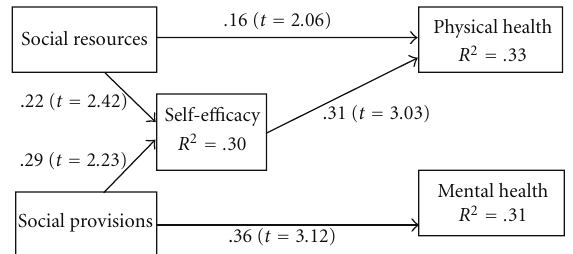
Figure 2: Test results for the support-e ffi cacy model with cente- narians residing in private homes; model fit: Satorra-Bentler χ 2 ( N = 126; df = 3) = 5.14; P = . 16; CFI = . 97; RMSEA = . 08; SRMR = . 03 (using F1ML). Nonsignificant paths deleted; parameter estimates are from the standardized solution. Test of Indirect E ff ect for Social Resources on Physical Health (.07; t = 1 . 93; P = . 053; two-tailed). Test of Indirect E ff ect for Social Provisions on Physical Health (.09; t = 1 . 66; P = . 097; two-tailed). Endogenous variables were controlled for sex, mental status, ADLs, education, and economic su ffi ciency.